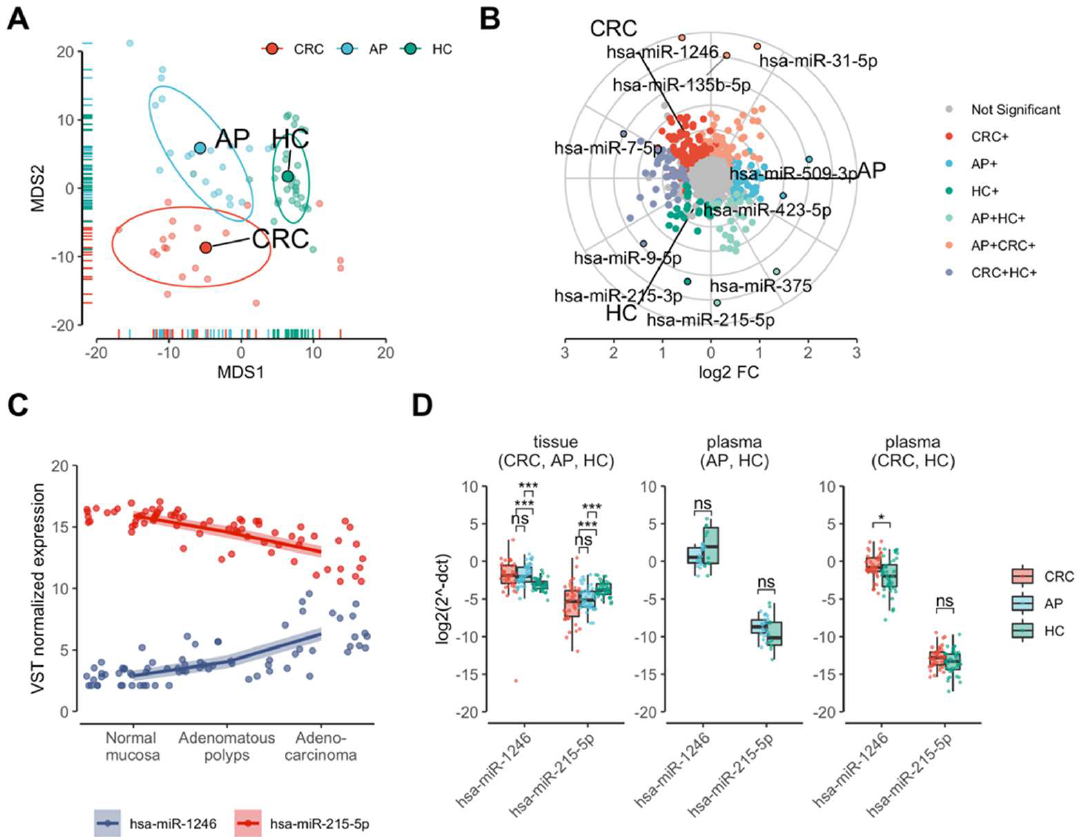
Figure 1. Expression profiling of miRNAs in precancerous and cancerous tissues of the colon. ( A ) MDS plot showing three clearly resolved clusters corresponding to colorectal cancer (CRC) and adenomatous polyps (AP) patients and healthy controls (HC). The analysis was performed on normalized miRNA count data using Euclidean distance. ( B ) A radar plot showing commonly and uniquely deregulated miRNAs (P FDR < 0.01 and |log 2 FC| > 0.5) among CRC, AP, and HC groups (indicated by colors) in small RNA-seq data. ( C ) miRNAs highly correlating (absolute value of r Spearman’s > 0.7) with the stages of healthy to adenoma-carcinoma sequence. Spearman’s rank correlation analysis was performed on variance stabilizing transformed miRNA counts. ( D ) The boxplots display expression levels (delta Ct) of hsa-miR-1246 and hsa-miR-215-5p measured by RT-qPCR in tissue and plasma samples of an independent validation cohort of HC, AP, and CRC individuals. Dots located along the box plots indicate miRNA expression level of each individual in the validation group. Due to the use of different RT-qPCR assays, the results of AP and CRC plasma samples are displayed separately. The ∆ Ct values were inversed in order to show true direction of the expression. Significance levels: * P FDR < 0.05; *** P FDR < 0.001; ns—not significant.